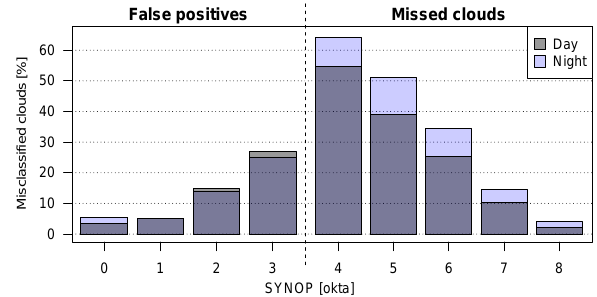
Figure 9. Distribution of the ground-based cloud mask errors as a function of SYNOP observations at 21 stations. The vertical dashed line represents the binary threshold applied to the SYNOP observa-